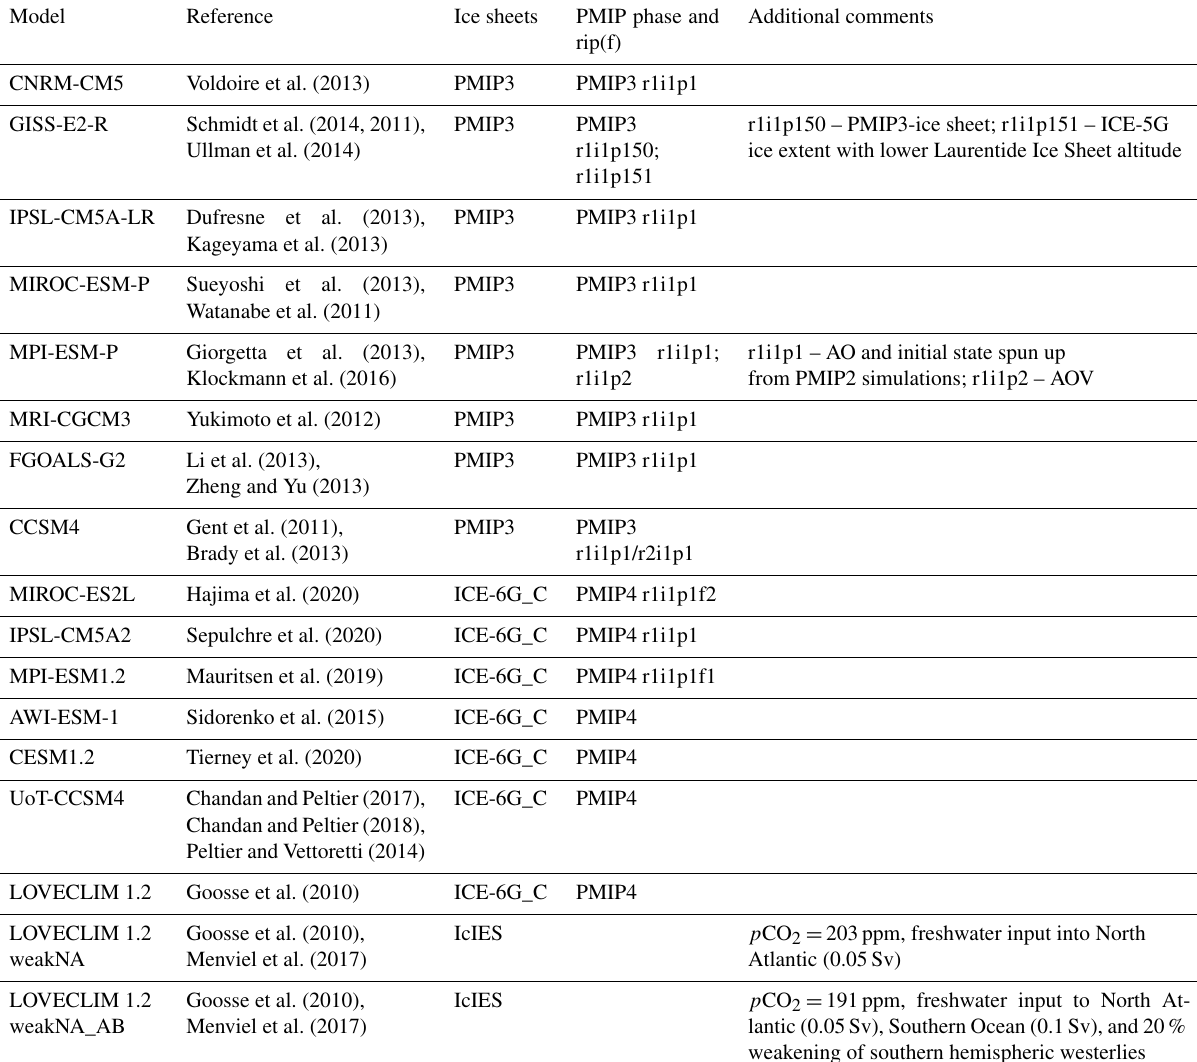
Table 1. Models analyzed in this study, the PMIP phase they pertain to, and the ice-sheet forcing that was used. When applicable, the ensemble member is specified using rip(f) nomenclature (https://pcmdi.llnl.gov/CMIP6/Guide/dataUsers.htm last access: April 4th, 2022). The Ice sheet model for Integrated Earth system Studies (IcIES) forced by climatic outputs from the Model for Interdisciplinary Research on Climate (MIROC) (Abe-Ouchi et al., 2013). The atmospheric CO 2 concentration ( p CO 2 ) for PMIP3 and PMIP4 experiments is 185 and 190ppm, respectively. p CO 2 for the two LOVECLIM sensitivity experiments is